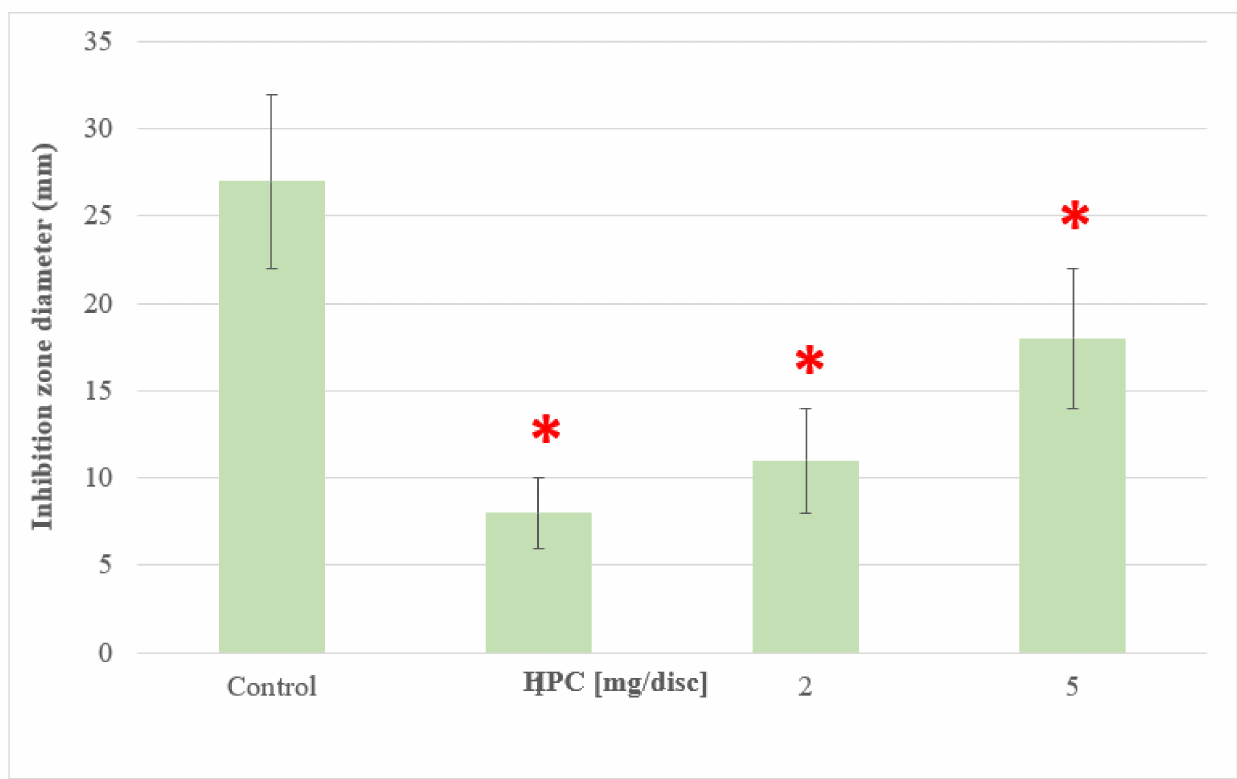
Figure 3. Antibacterial effects of the HPC. The inhibition zones’ diameters were measured to evaluate the antimicrobial activities of the anti-hemorrhoidal polyherbal cream (HPC) against E. coli , compared with 5 mg Ampicillin/disc (control). Values represent means ± SD of three independent experiments carried out in triplicates. * p < 0.01—significant as compared with